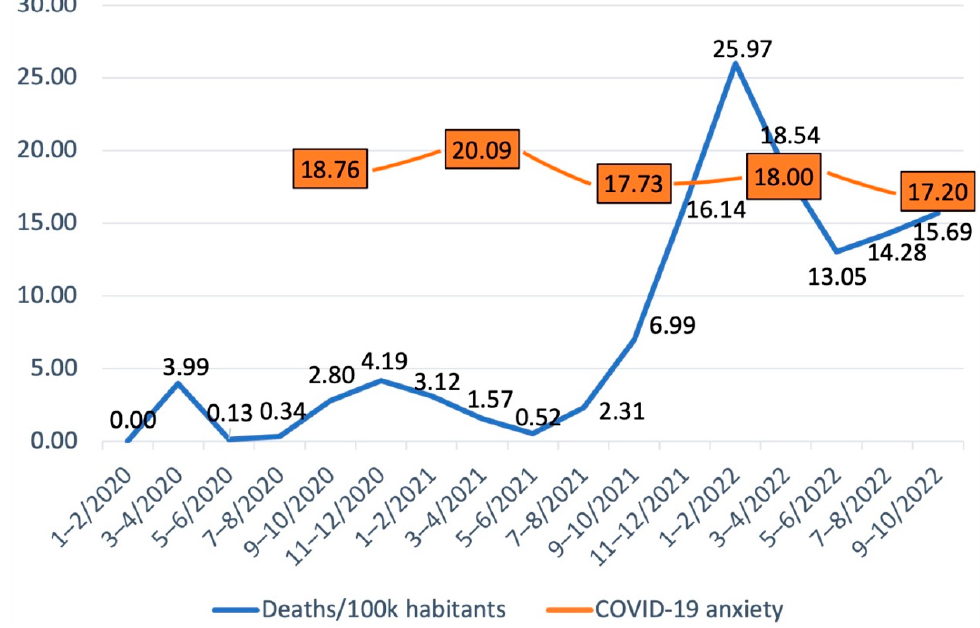
Figure 1. COVID-19 mortality and COVID-19 anxiety in 2020–2022. Note. Figure 1 COVID-19 mortality figures are based on the information reported by the Finnish Institute of Health and Welfare [62].